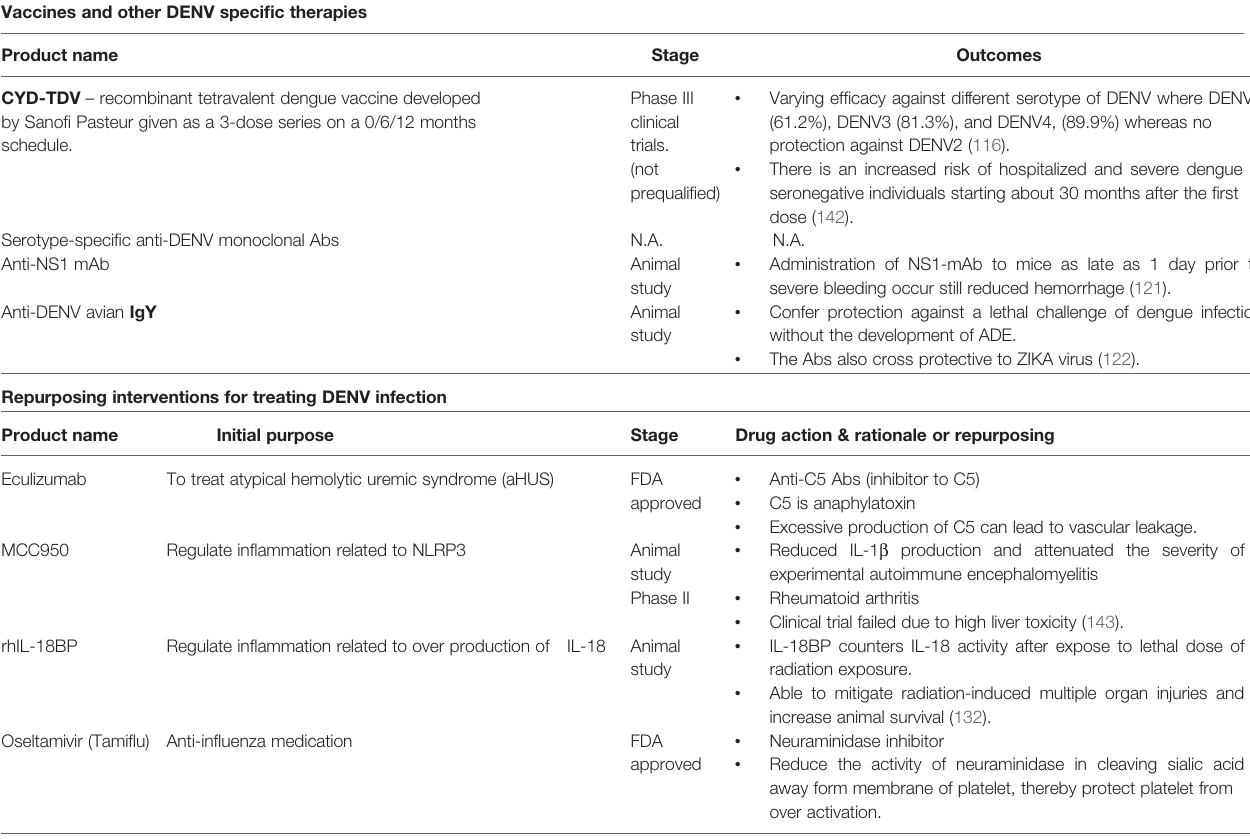
TABLE 2 | Interventions for dengue disease and their stage of